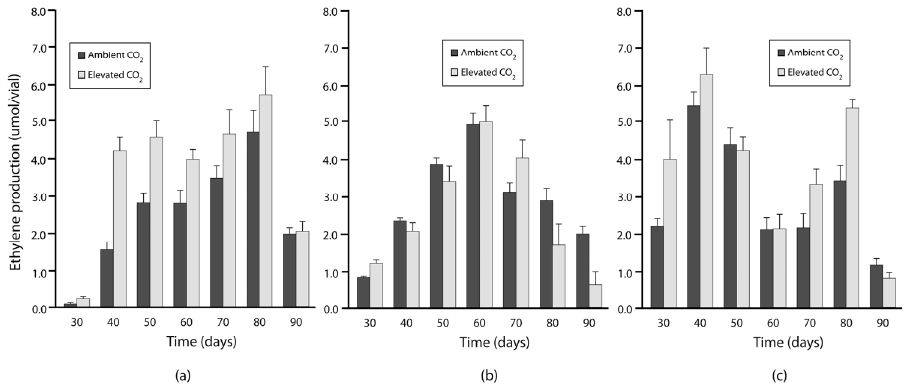
Figure 5. Nitrogen fixation of axenic N. punctiforme as measured by the ethylene (C 2 H 4 ) produced over 90 days. Vials were grown at ( a ) 11.5 °C showing maximum N 2 fixation at day 80; ( b ) 15.5 °C showing maximum N fixation at day 60; ( c ) 19.5 °C showing maximum N 2 fixation at day 40 and day 80. All data are plotted as mean ± SD. Table 1. Results of repeated-measures Analysis of Variance tests used for the effects of elevated CO 2 and temperature treatments over 90 day incubation periods for rates of N fixation by axenic cultures of N. punctiforme